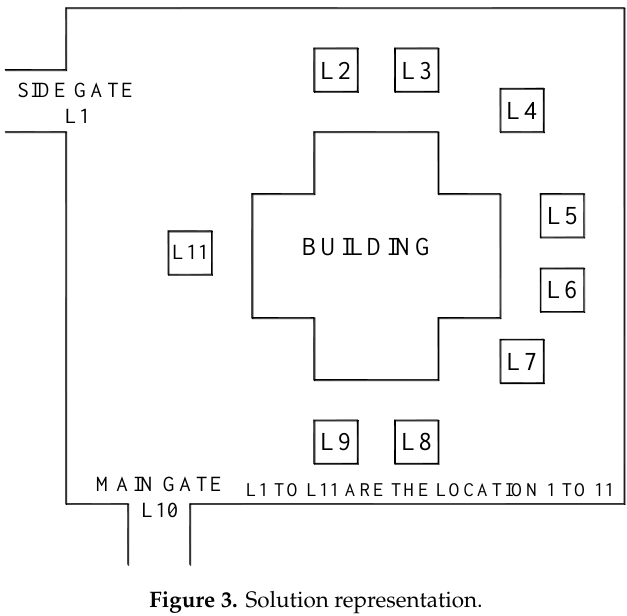
Figure 3. Solution representation.